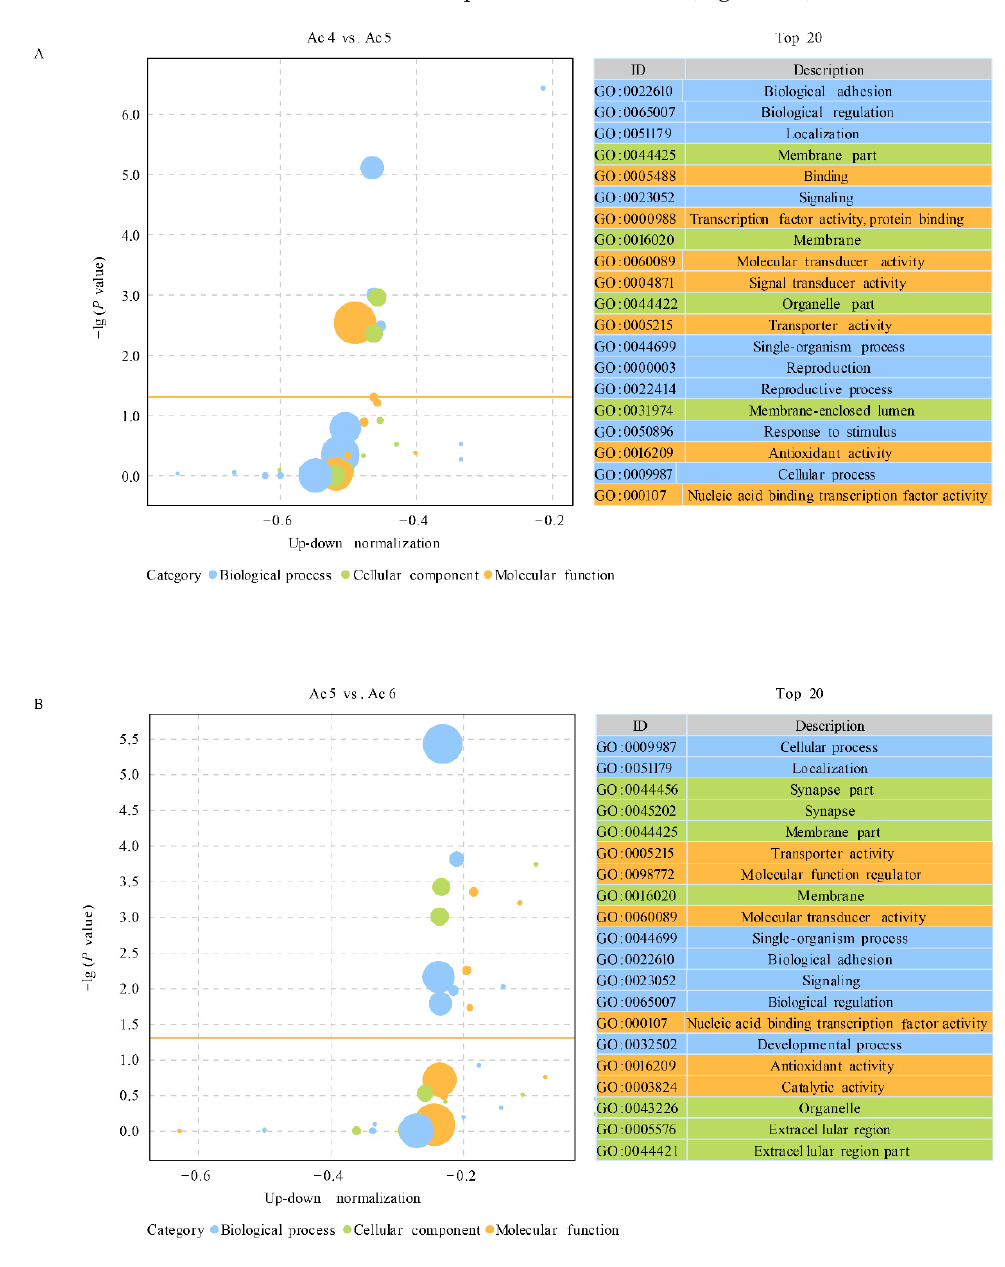
Figure 4. GO terms annotated by target mRNAs of DEpiRNAs. ( A ) Bubble diagram of DEpiRNA- targeted mRNAs in Ac4 vs. Ac5 comparison group. ( B ) Bubble diagram of DEpiRNA-targeted mRNAs in Ac5 vs. Ac6 comparison group.